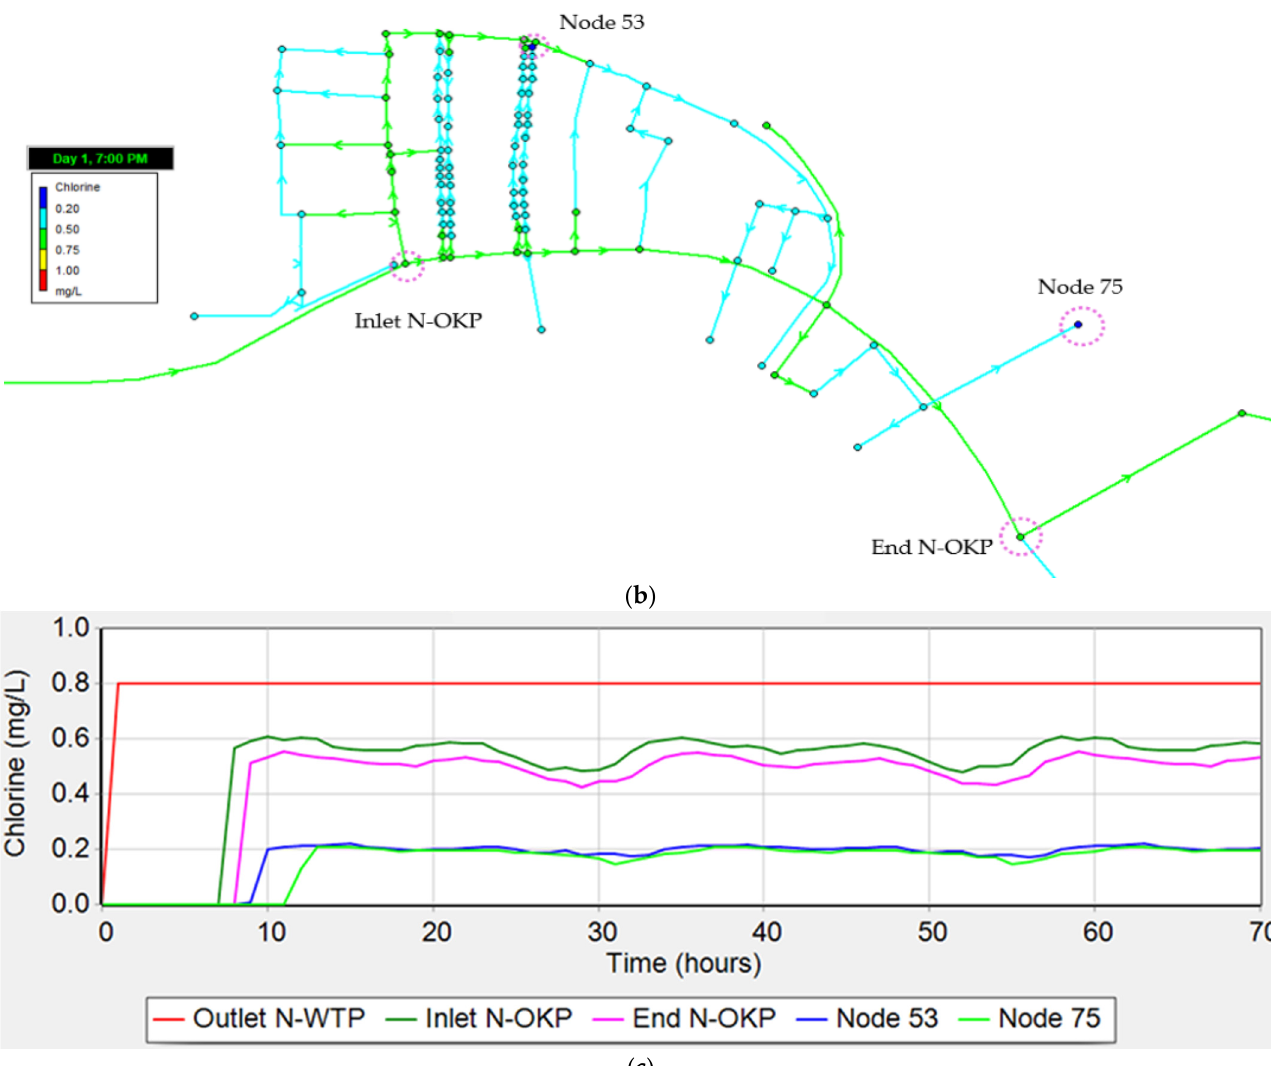
Figure 13. Simulation of chlorine in Phase 1 (initial chlorine 0.8 mg/L): ( a ) Phase 1 model, ( b ) chlorine in N-OKP area, ( c ) chlorine concentration in model.